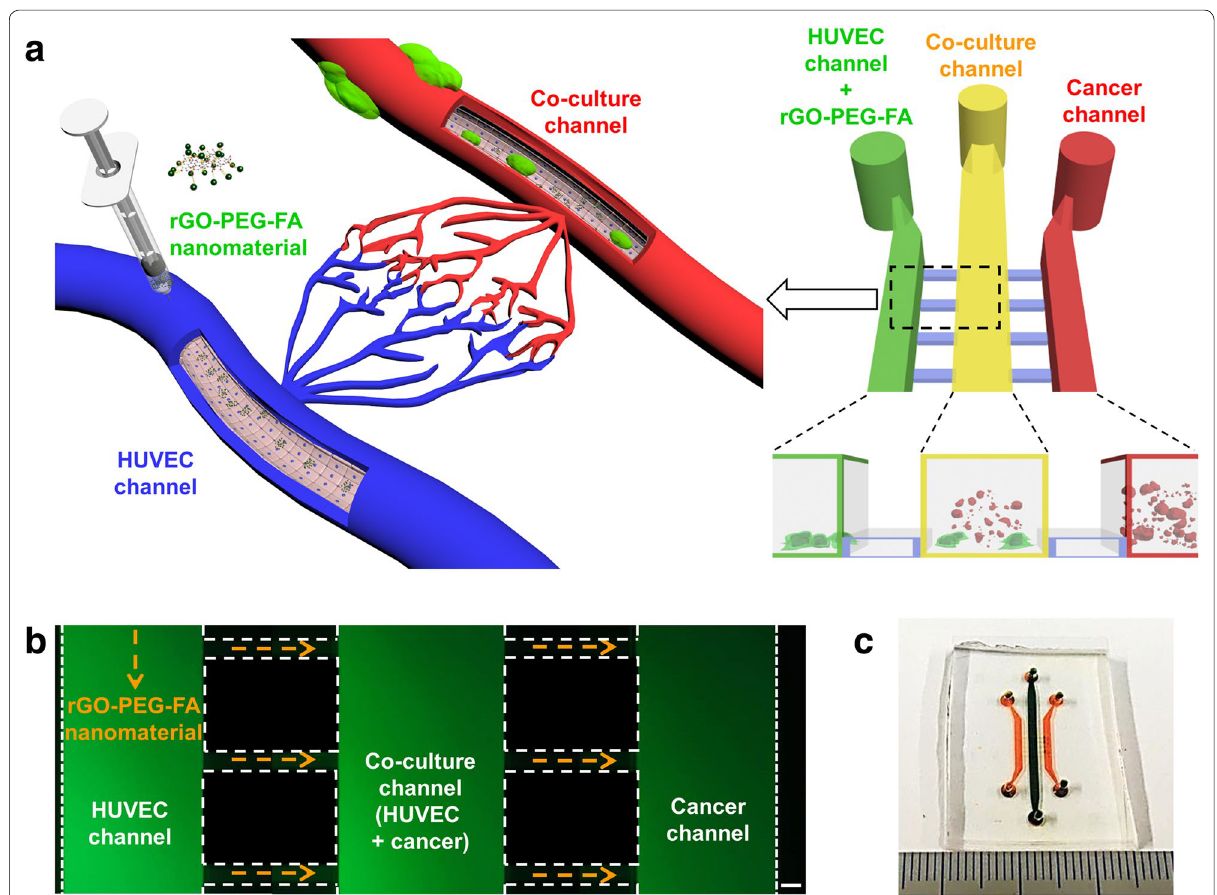
Fig. 1 Schematic of the injection of therapeutic agents‑mimicking microfluidic co‑culture platform consisting of three cell culture channels and bridge channels ( a ). Microscope image of the microfluidic co‑culture platform with green color dye ( b ). Photograph of the whole fabricated microfluidic co‑culture platform ( c ). Scale bars are 50